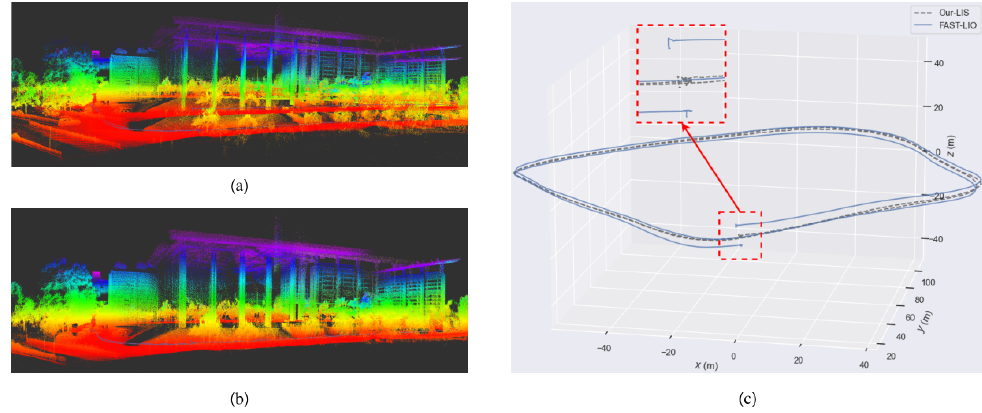
Figure 11. ( a ) The map result of FAST-LIO2 on ZJG-lib dataset. ( b ) The map result of our LIS with ground constraint on ZJG-lib dataset. ( c ) The path result of FAST-LIO2 and our LIS. It is clear that due to the ground constraint, our LIS has less drift than